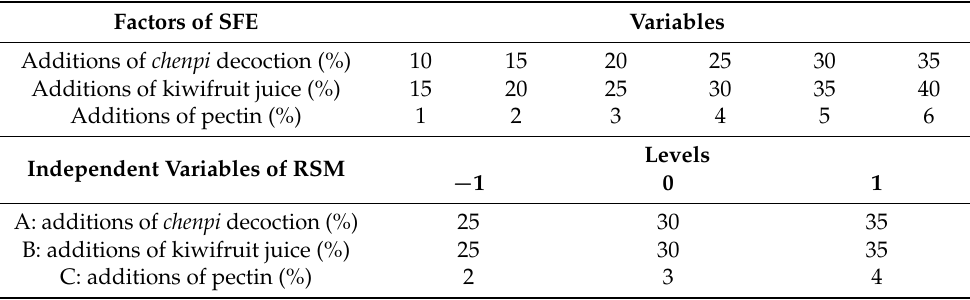
Table 2. Variables of single-factor experiments and response surface